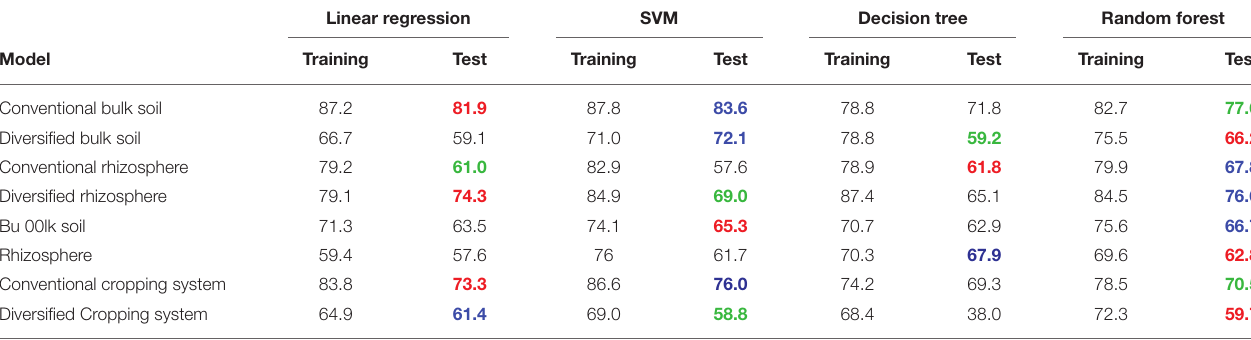
TABLE 2 | Machine learning model accuracy (% 1-MAPE) with ammonia oxidizer amoA gene abundance. Linear regression